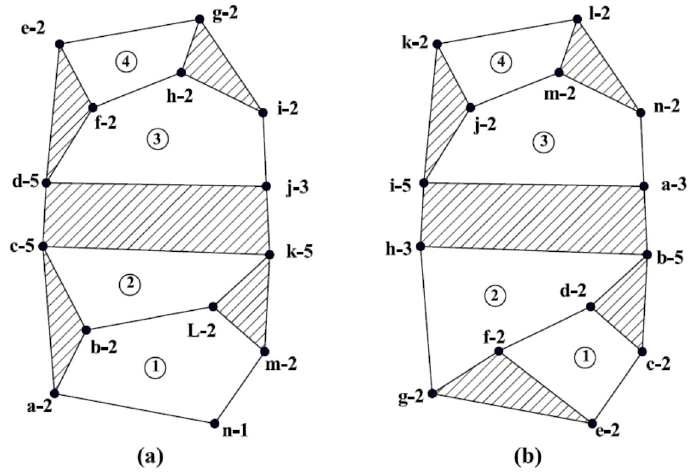
Figure 9. Two 11-link kinematic chains with simple joints. ( a ) Kinematic chain: a. ( b ) kinematic chain: b.